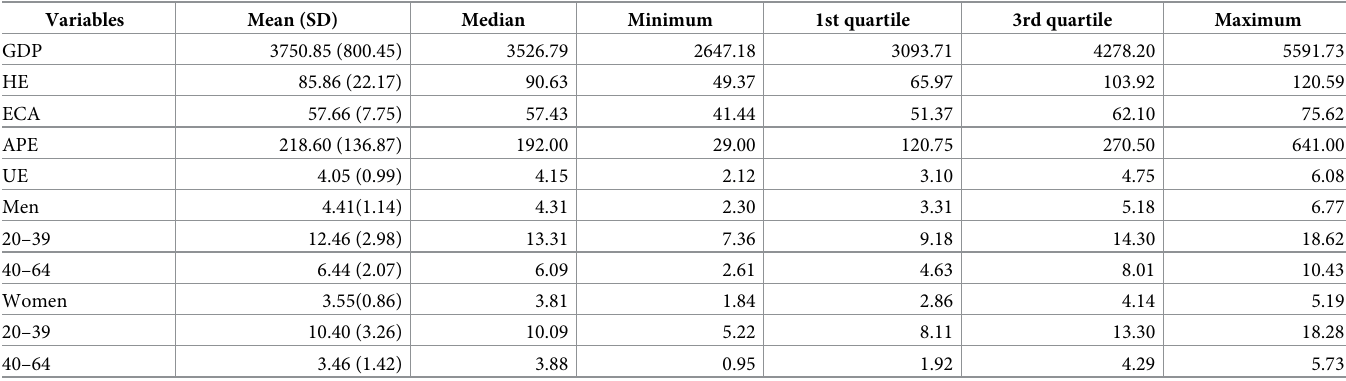
Table 1. Description of socioeconomic factors in Taiwan, 1996–2012.